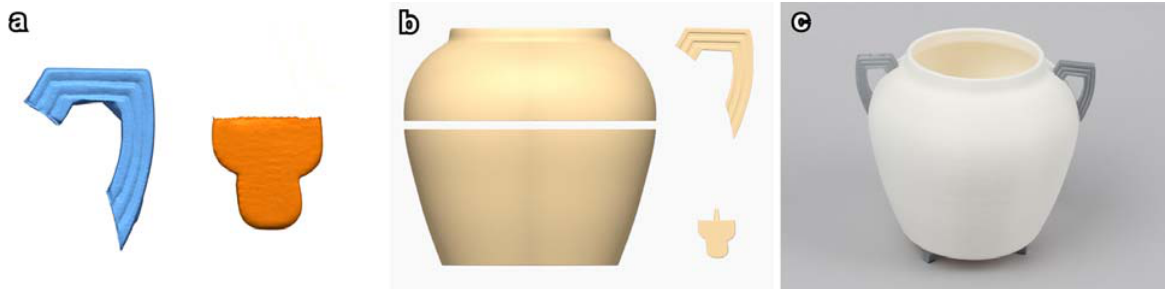
Figure 2. Design Mock-up modelling and results. (a) Reference models. (b) Replication models. (c) Design mock-up